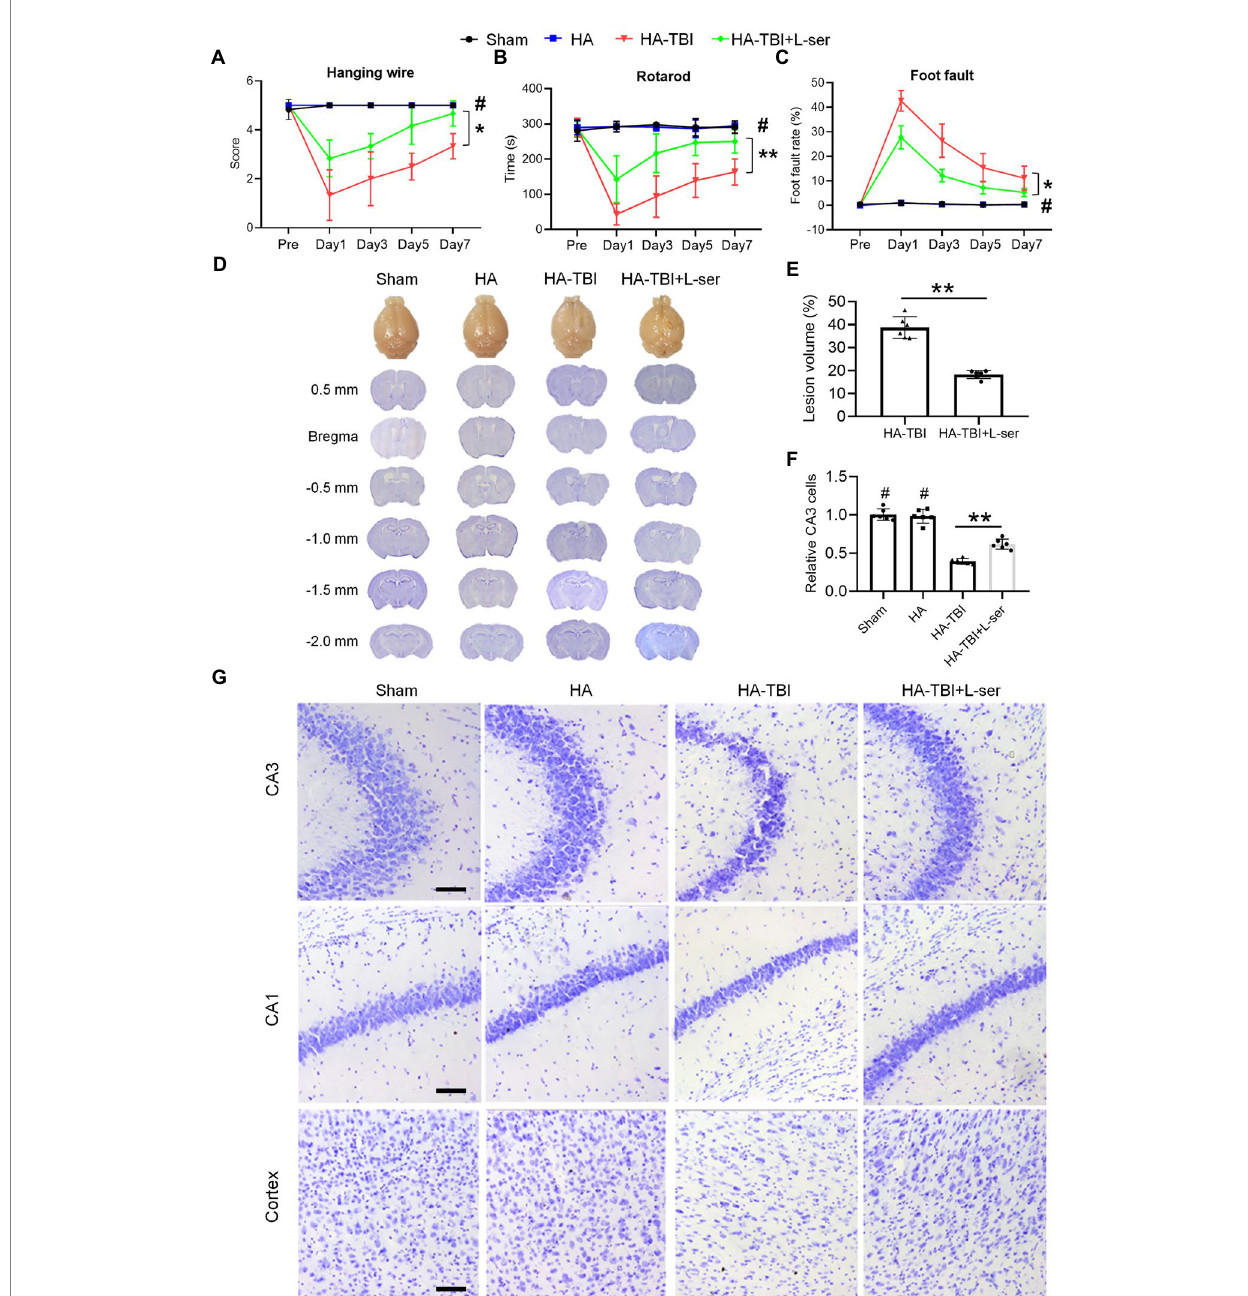
FIGURE 3 Effects of L-serine on neurobehavioral function in mice after HA-TBI and its neuroprotective effect on cerebral gray matter. (A) Hanging wire test ( n = 7–8). (B) Rotarod test ( n = 7–8). (C) Foot fault test ( n = 7–8). (D) Nissl staining of coronal sections of brain slices from bregma 0.5 mm to − 2.0 mm, showing the lesion of brain tissue in the different groups. (E) Quantification of the lesion volume ( n = 6). (F) Relative quantification of viable CA3 cells ( n = 6). (G) Representative Nissl staining of the right side of CA3, CA1 and cortex in different groups, scale = 50 μ m. * p < 0.05, ** p < 0.01 versus the indicated group; # p < 0.01 versus other